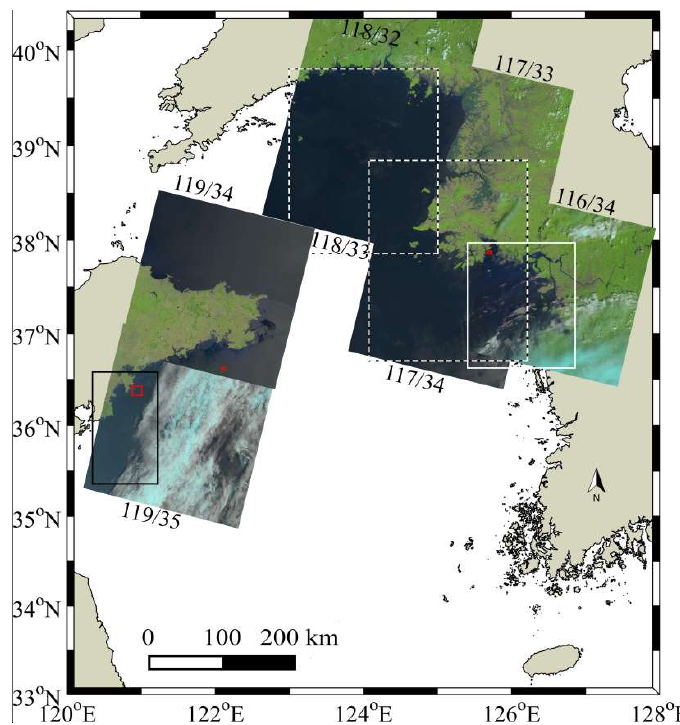
Figure 1. Study area map displaying Landsat-8 path/row coverage by some natural colour composite images (RGB 4, 3 and 2 respectively for 655, 561 and 482 nm) on 2 August 2014 (116/34), 6 June 2014 (117/33 and 117/34), 5 August 2016 (118/32 and 118/33), 25 June 2016 (119/34), and 25 July 2015 (119/35). Three large white rectangles indicate the study areas, and the three small red rectangles and the large black rectangle indicate the ROI for showing the comparison between detection results by different vegetation indices: NDVI, FAI, and mod-FAI.